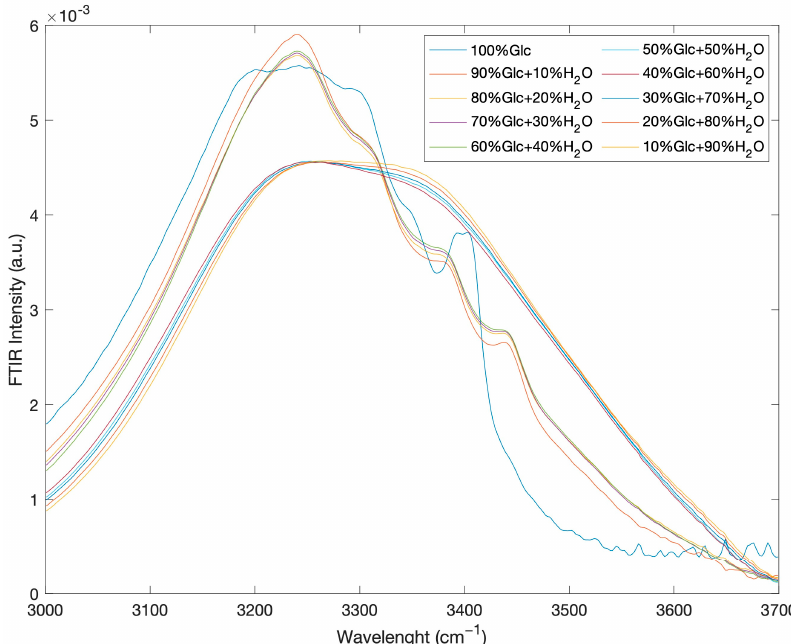
Figure 4. FTIR intramolecular OH stretching band as a function of concentration for glucose-water mixtures at the temperature value of T = 20 °C.